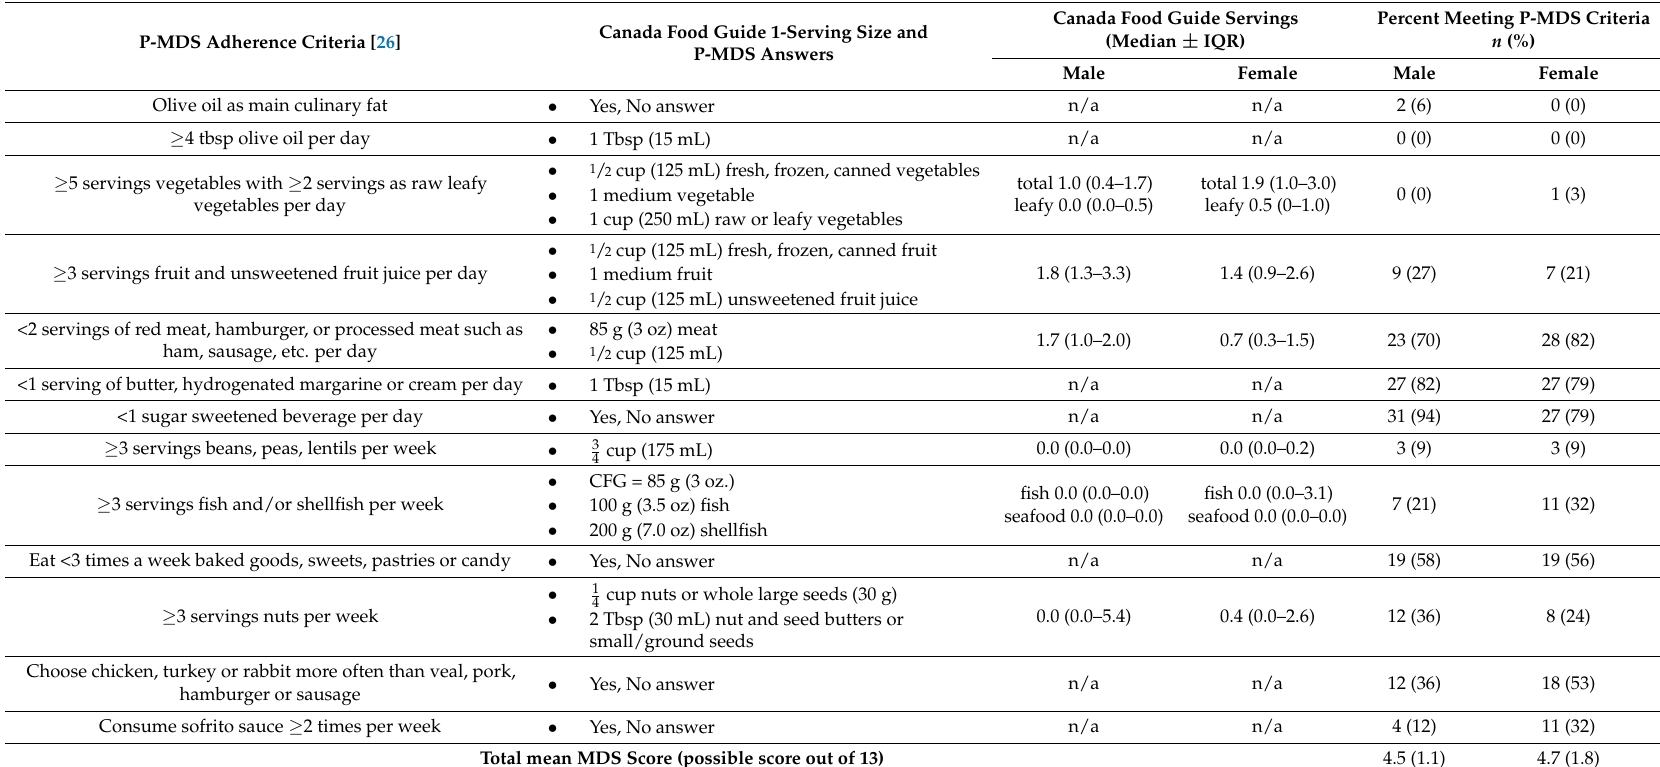
Table 5. Predimed Mediterranean Diet (P-MDS) adherence